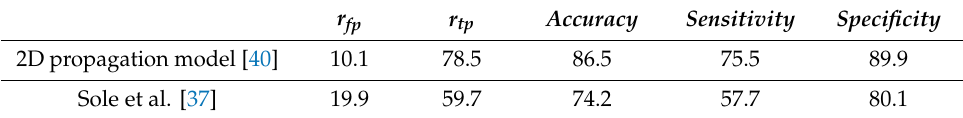
Table 2. Results of the GIS tool performance compared, respectively, with the 2D propagation model approach and with respect to Sole et al., 1997 in terms of a flood extent map for the San Giuliano case and specificity. r fp